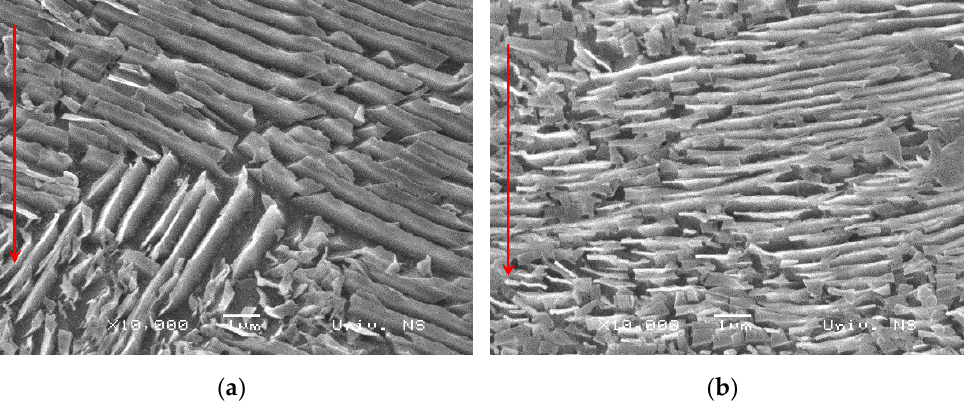
Figure 15. Microstructure of specimen in Zone I ( a ) and Zone IV ( b ) for strain level ε z 1 = 0.38 (red arrow—direction of upsetting).